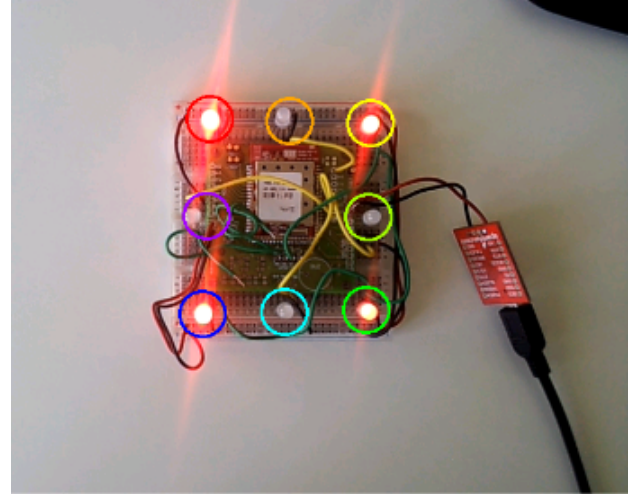
Figure 4. Sampling points for fixed, blinking and data